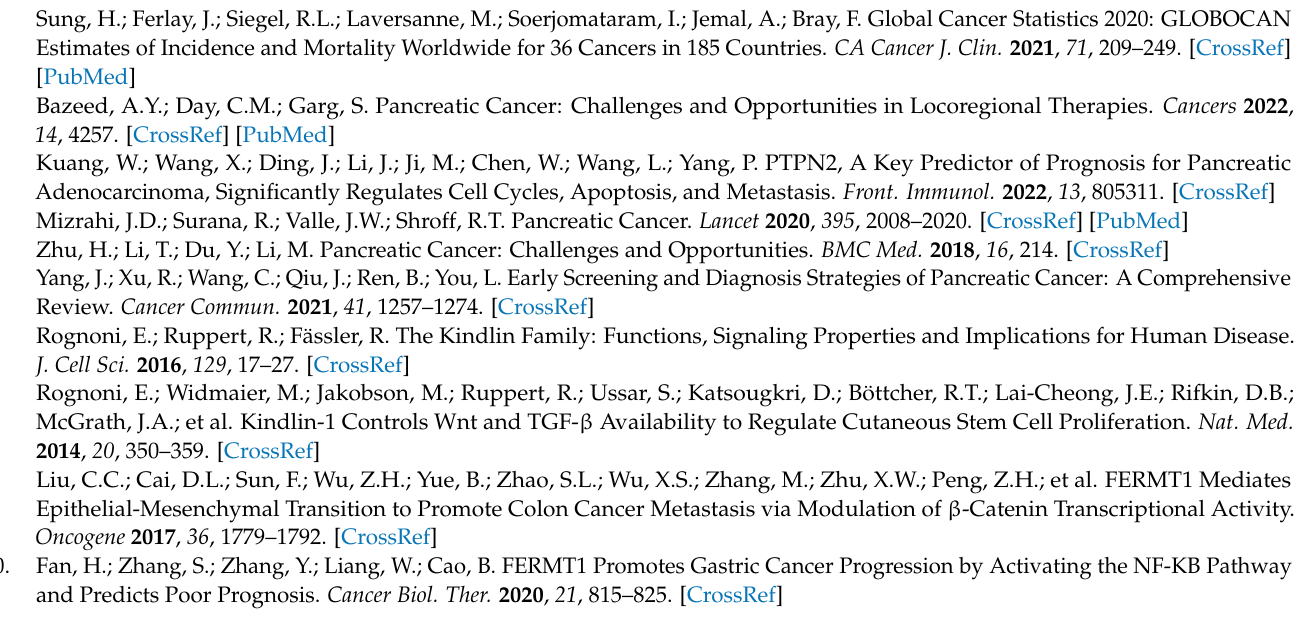
Table S3: Differential genes in the GSE62452 data